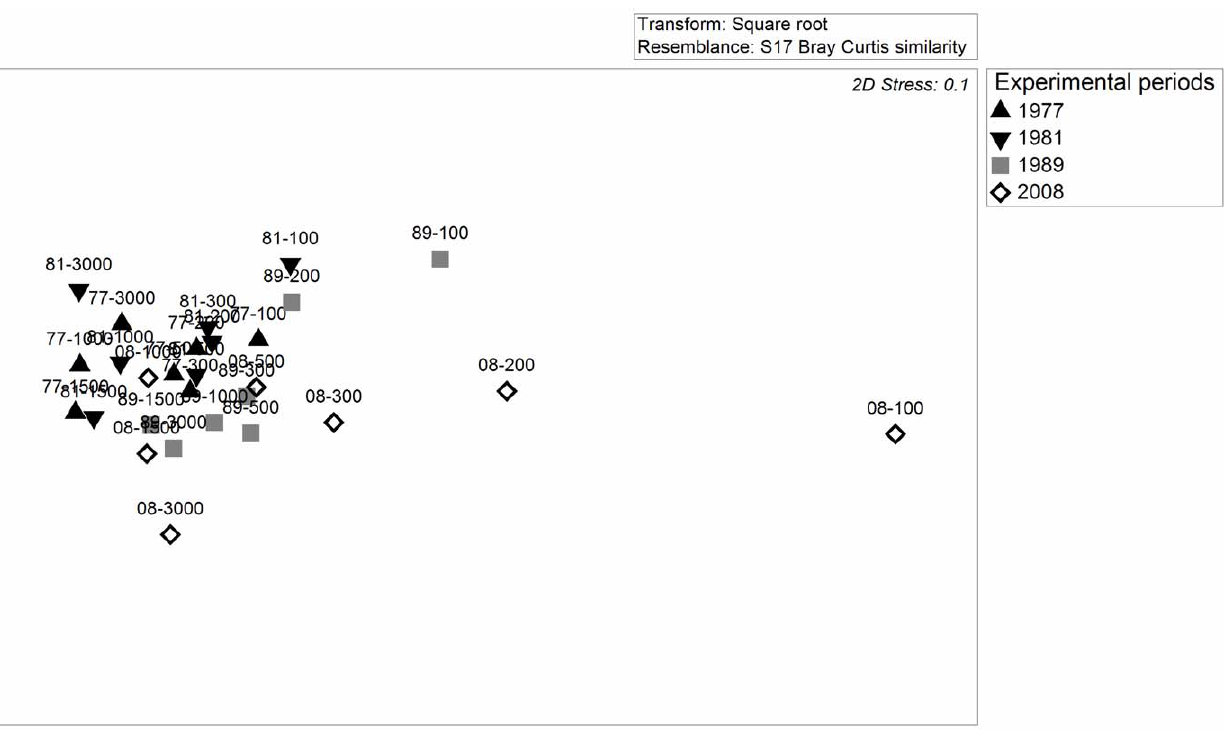
Figure 2. Non-metric Multidimensional Scaling ordination of the change in shrub composition over the experimental period (1977– 2008). Sample codes refer Sample Period-Distance to water (m).